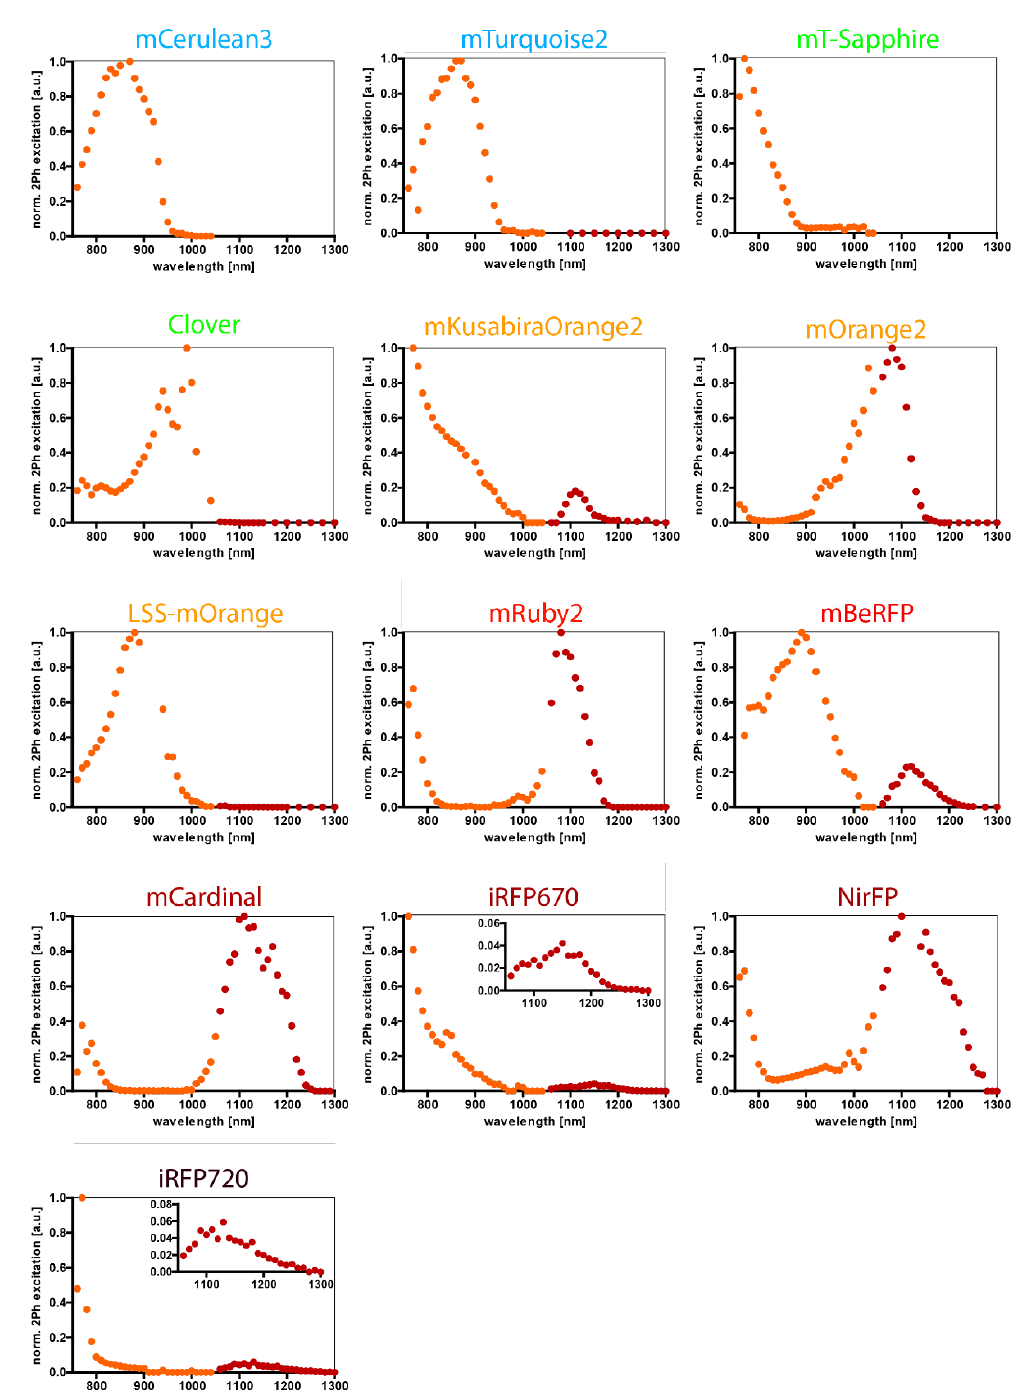
Figure 3. Two-photon excitation spectra of various fluorescent proteins expressed in the cytosol of transfected HEK-293T cells and, in the case of mKusabiraOrange, in isolated splenocytes from fluorescent reporter mice. Normalized excitation efficiency in arbitrary units (a.u.) are plotted versus the excitation wavelength in nanometers (nm). The fluorophores were excited by the Ti:Sa laser (760–1040 nm; orange dots) and OPO pumped by Ti:Sa (1060–1300 nm; dark-red dots). The spectra are ordered according to their emission maximum from the blue to deep red/infrared spectral range, illustrated by the color of the designations. A table of the spectra in numbers can be found in the Supplementary Material Tables S1 and